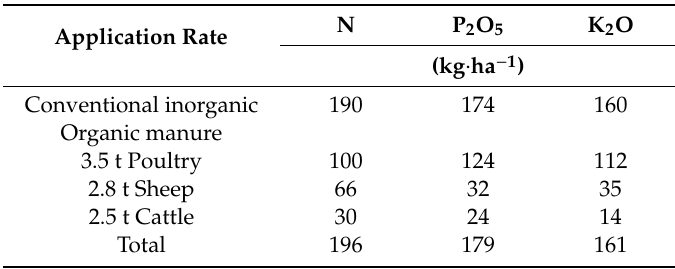
Table 1. N, P, and K application rates for cherimoya trees under conventional and organic